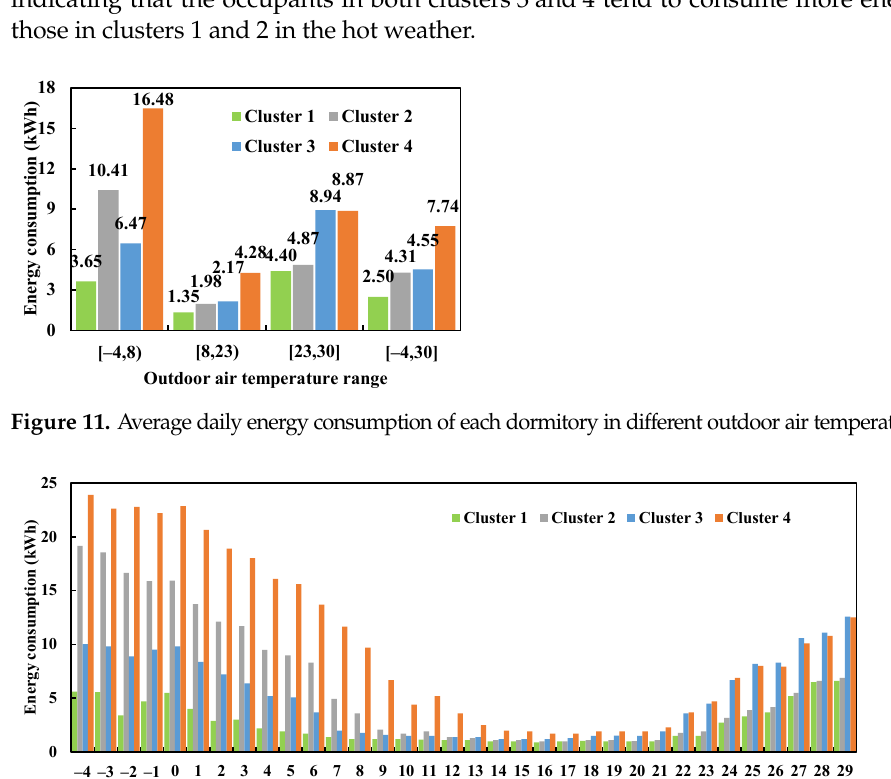
Figure 13. Comfort outdoor air temperature range. Table 1. Multi-nominal logistic regression analysis results. Cluster 1